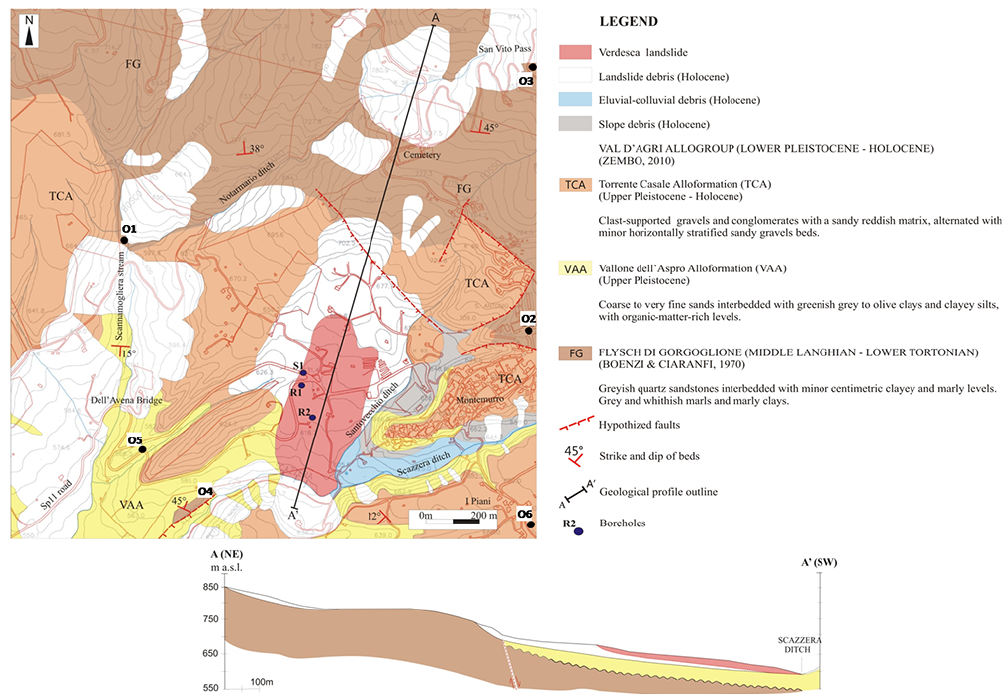
Figure 3. Geological sketch map and geological section (A–A (cid:48) ) of the study area. Letters O1 to O6 indicate outcrops locations cited in the text, and boreholes are indicated as S1, R1 and R2.